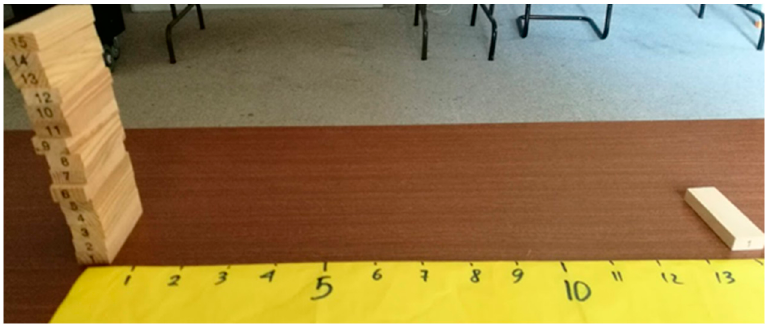
Figure 4. At the left end of the ruler 15 blocks representing 15 PCR ‐ positive people, and 14 days later one of these people dies (shown at the right end).